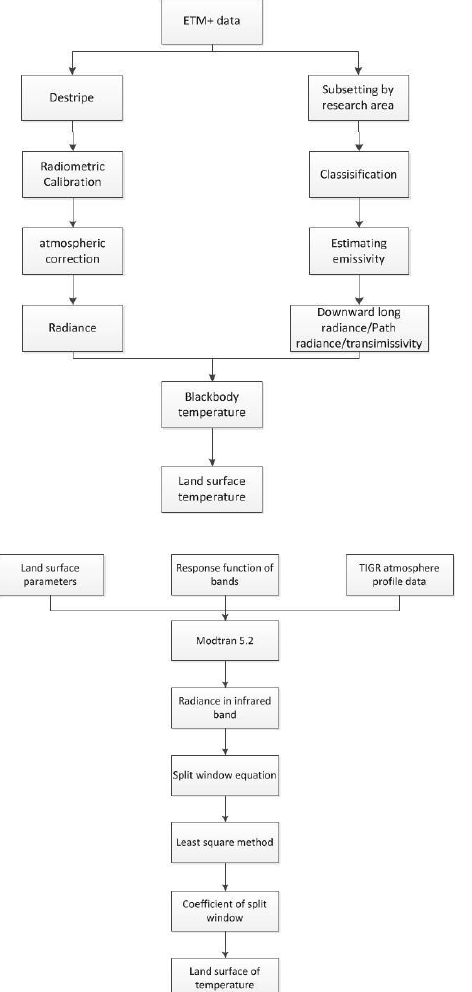
Figure 3 The flow charts of retrieving LST by ETM+ and TM